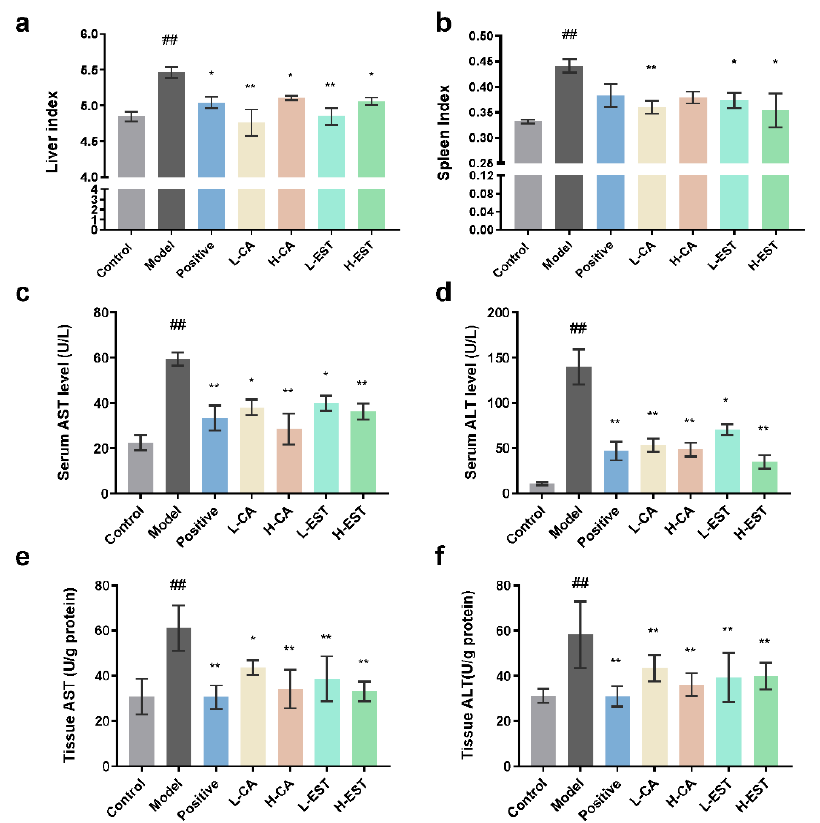
Figure 1. EST and CA ameliorated the CCl 4 -induced liver injury: ( a ) the liver index, ( b ) the spleen index of different groups, ( c ) serum AST, ( d ) serum ALT, ( e ) liver tissue AST, and ( f ) liver tissue ALT level of each group. Data are expressed as mean ± SD of at least three independent experiments ( n ≥ 5). ## p < 0.01 compared with the control group; * p < 0.05, ** p < 0.01 compared with the model group.